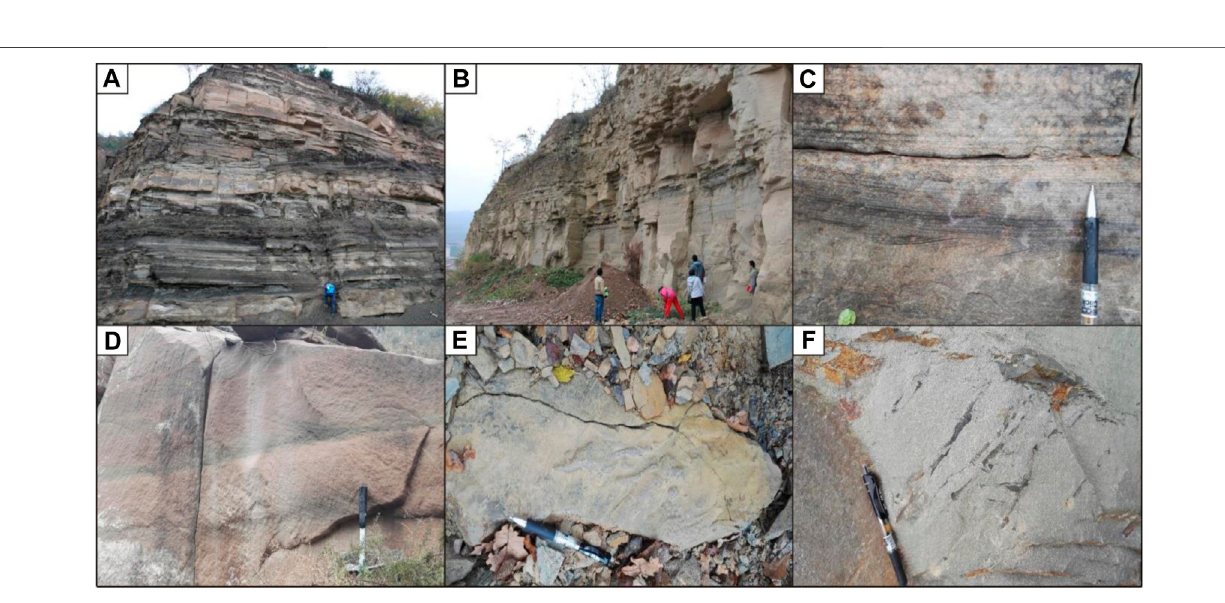
Frontiers in Earth Science |